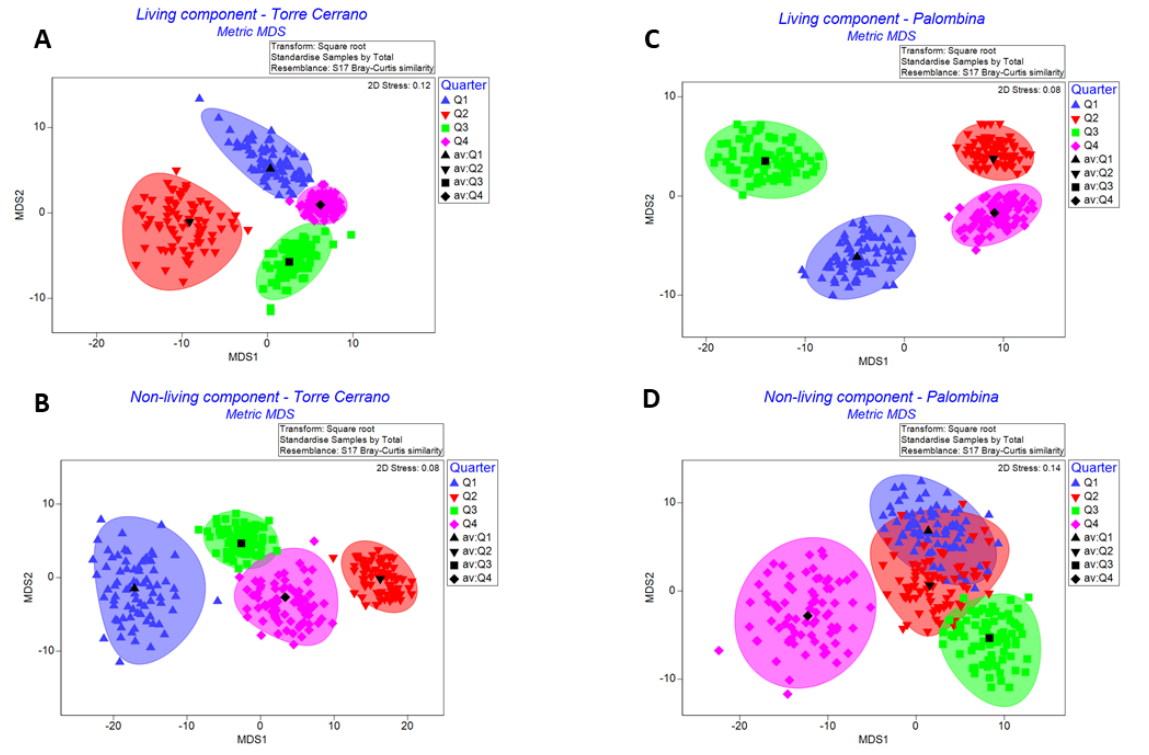
Figure 4. 2D-metric multidimensional scaling ordination plots based on bootstrap averages visualise patterns in the living ( A , C ) and non-living components ( B , D ) among the quarters (Q1–Q4) in the sites Palombina and Torre Cerrano). Group averages (black symbols) and approximate 95% confidence intervals (colored ellipses) are provided .